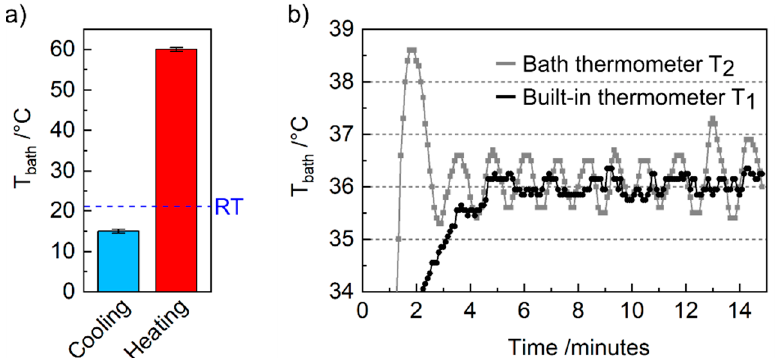
Figure 3. Regulation of the temperature in a 35 mm Petri dish. ( a ) Maximum cooling and heating capability using a 3 A power supply and a passive heat sink. Error bar is ±0.5 °C. ( b ) Temperature course of the bath solution during heating to 36 °C using the bath thermometer and the built-in thermometer as feedback line for the controller, respectively. The temperature was measured with the bath thermometer T 2 .